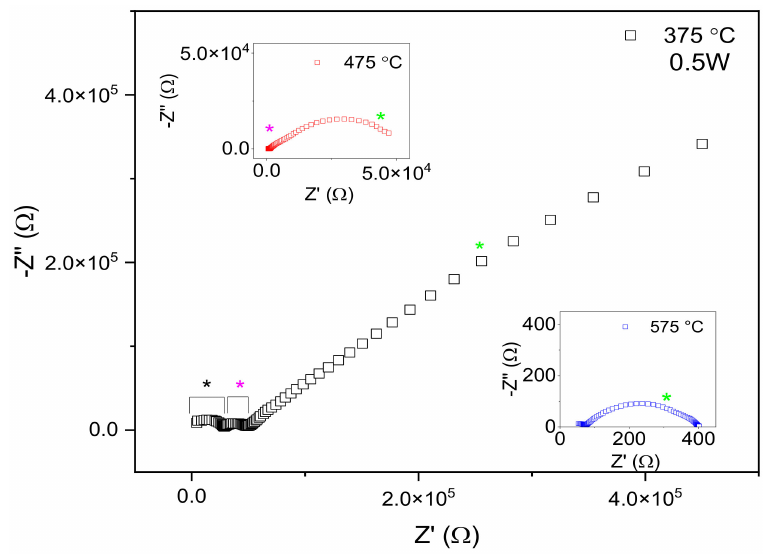
Figure 5. Nyquist plot at different temperatures for 0.5 W sample. *: bulk; *: grain boundary and *: electrode effect.